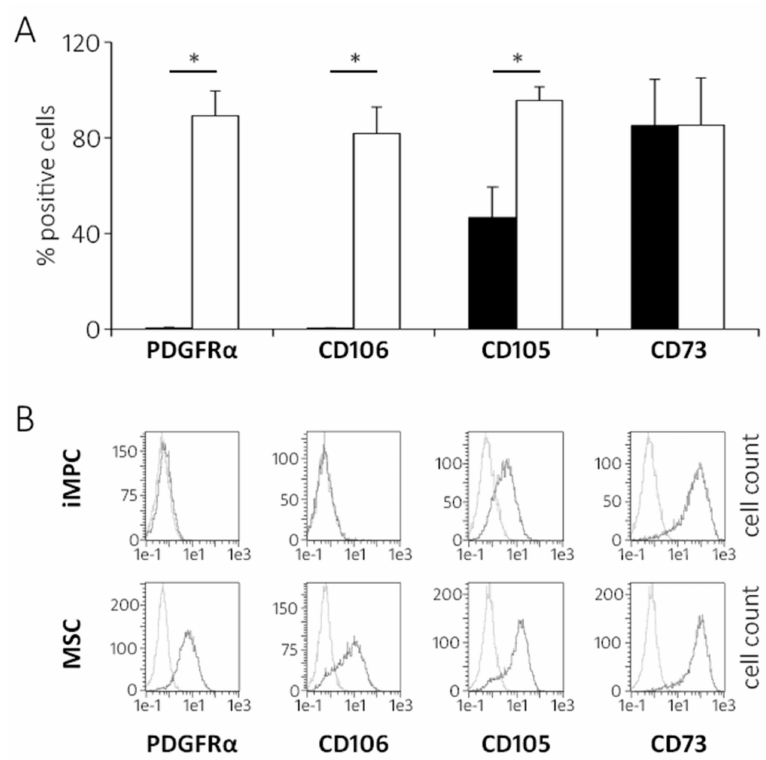
Figure 3. The surface expression of selected mesenchymal markers in iMPCs versus MSCs. Passage 3 cells were harvested, fixed, stained with antibodies and subjected to flow cytometry. ( A ) The proportion of mesenchymal marker-positive cells of iMPCs and MSCs ( n = 3 independent iMPCs [black bars] and MSC [white bars] donor populations; the mean ± standard deviation; * p ≤ 0.05 between groups, Mann-Whitney U-test). ( B ) The representative histograms; light grey lines represent unstained control cells. The gates were adjusted to the control cell population to determine the percentage of positively stained